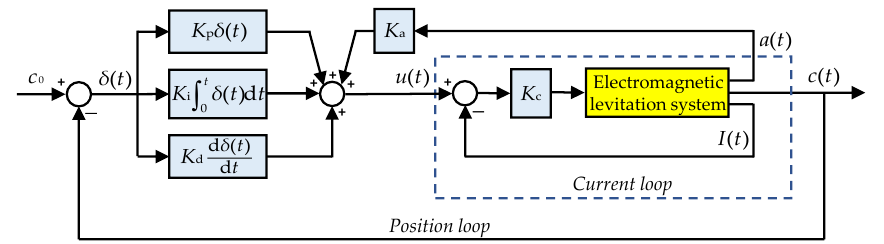
Figure 5. Flow chart of the levitation control system.